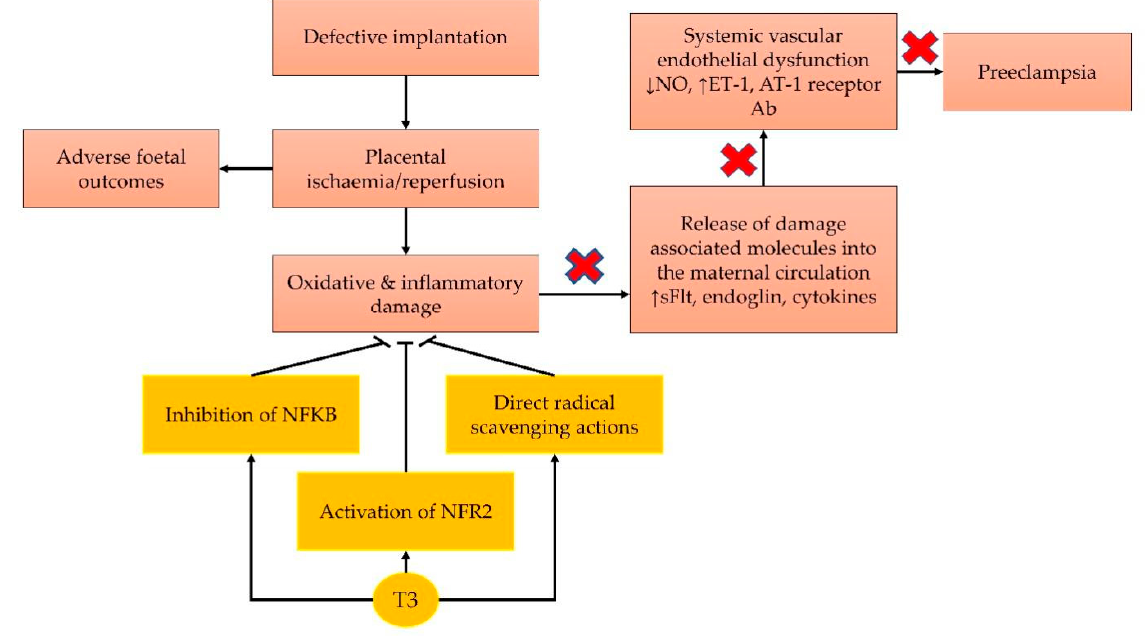
Figure 3. Theoretical framework of how tocotrienol prevents pre-eclampsia. Tocotrienol exerts anti-inflammatory and antioxidant actions, which prevent the oxidative and inflammatory damages caused by ischaemia. The same properties also prevent hypertension in pre-eclampsia. Abbreviation: Ab, antibody; AT-1, angiotensin-1; ET-1, endothelin-1; NF- κ B, nuclear factor kappa-B; NO, nitric oxide; NRF2; nuclear factor erythroid 2–related factor 2; T3, tocotrienol; sFlt-1, soluble fms-like tyrosine kinase 1.